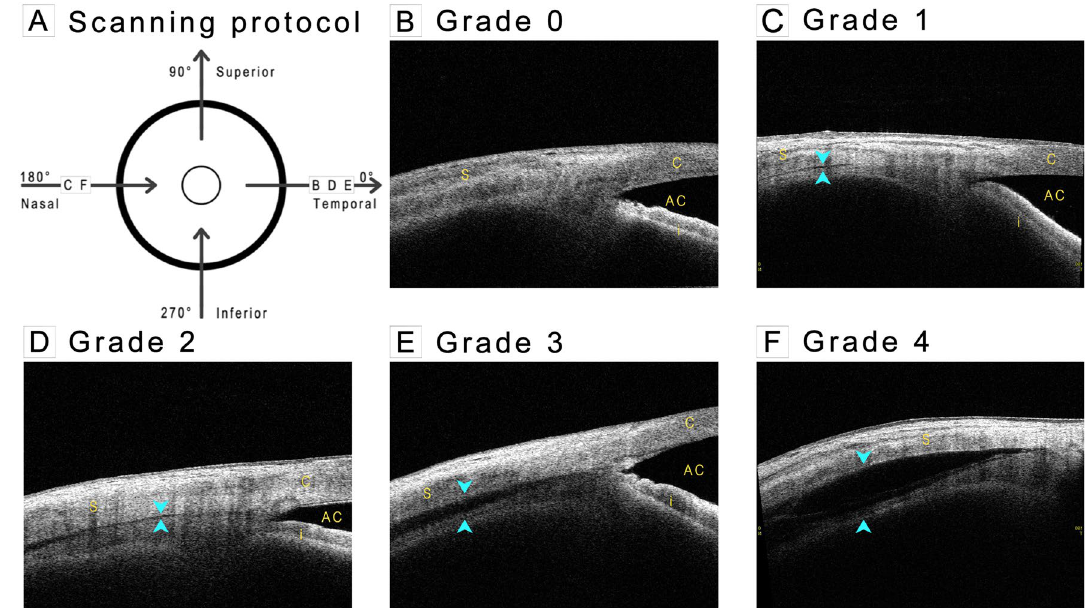
Figure 1. Anterior segment optical coherence tomography scanning protocol and representative images of hyporeflective signal grading of supraciliary change. Arrowhead indicates hyporeflective signal at supraciliary region. S scleral, C cornea, AC anterior chamber, I